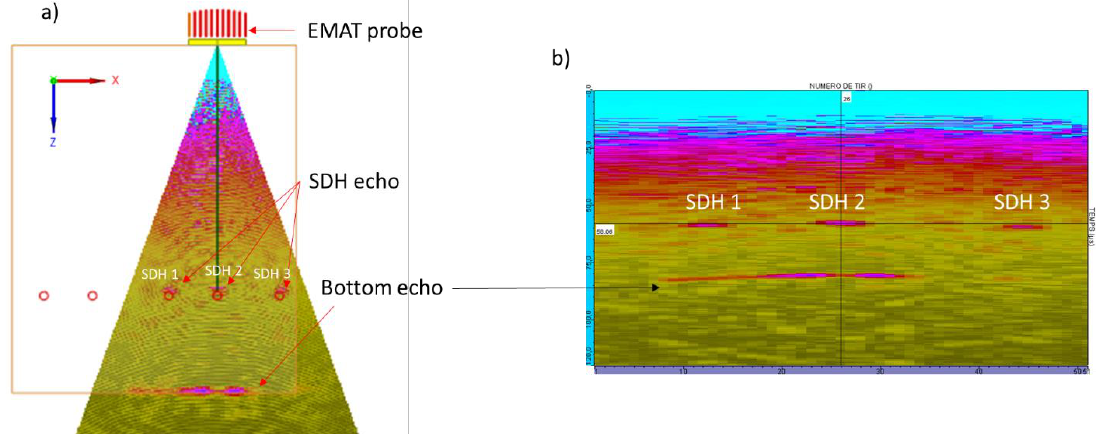
Figure 17. Experimental results. S-scans obtained on the aluminum block (250 mm thickness) with 3 SDHs (6 mm diameter) at 180 mm depth.